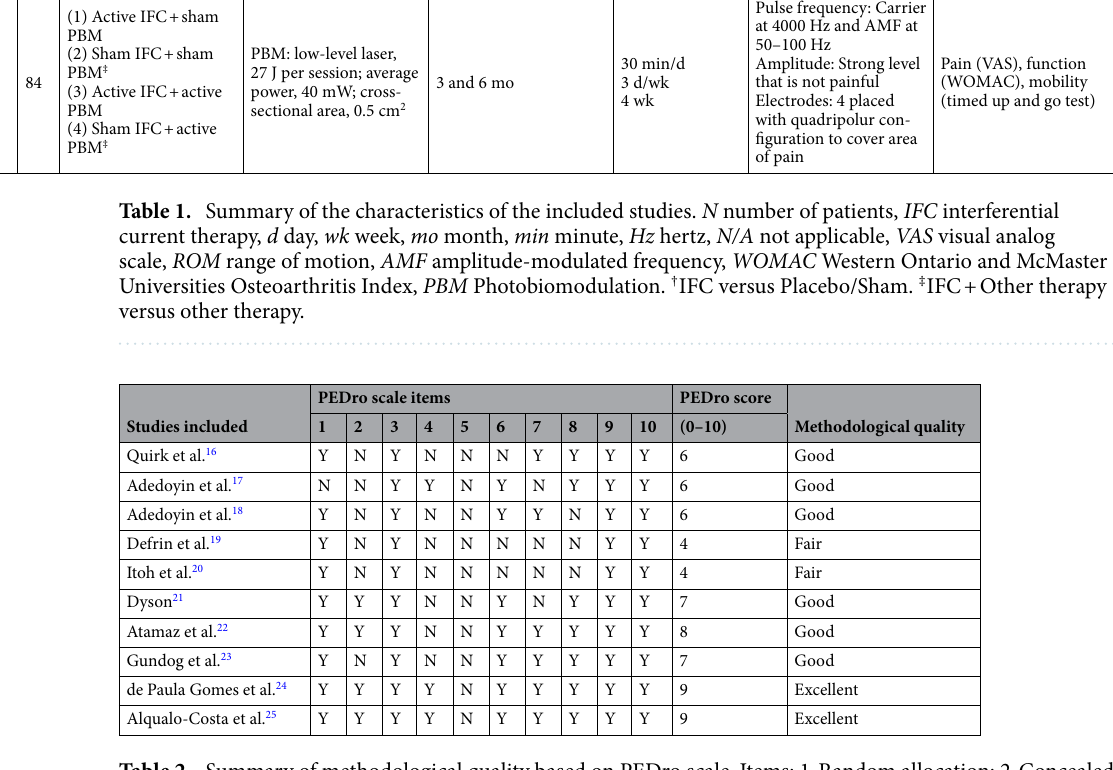
Table 2. Summary of methodological quality based on PEDro scale. Items: 1-Random allocation; 2-Concealed allocation; 3-Baseline comparability; 4-Blinded participants; 5-Blinded therapists; 6-Blinded assessors; 7-Adequate follow-up; 8-Intention-to-treat analysis; 9-Between-group comparisons; 10-Point estimates and variability. Methodological quality: Excellent, 9–10 points; Good, 6–8 points; Fair, 4–5points; Poor, 0–3 points; Yes ( Y ), 1 point; No (N), 0